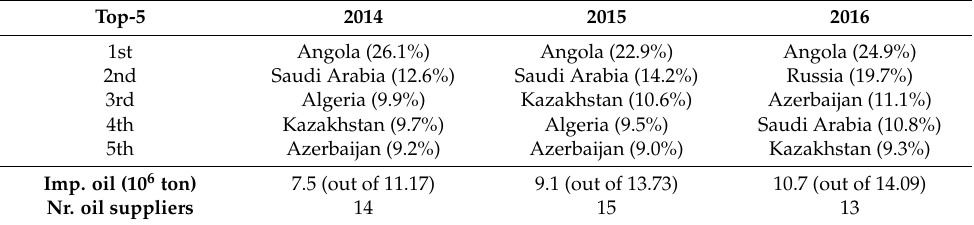
Table 1. Top five oil suppliers to Portugal and their corresponding share (based on data taken from [26]).